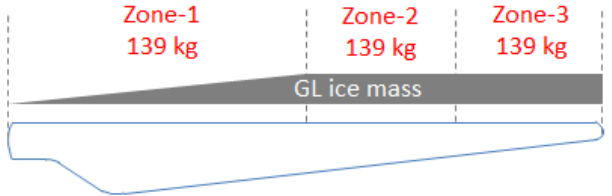
Figure 17. Germanischer Lloyd (GL) specification for ice mass on the Tjaereborg 2-MW wind turbine